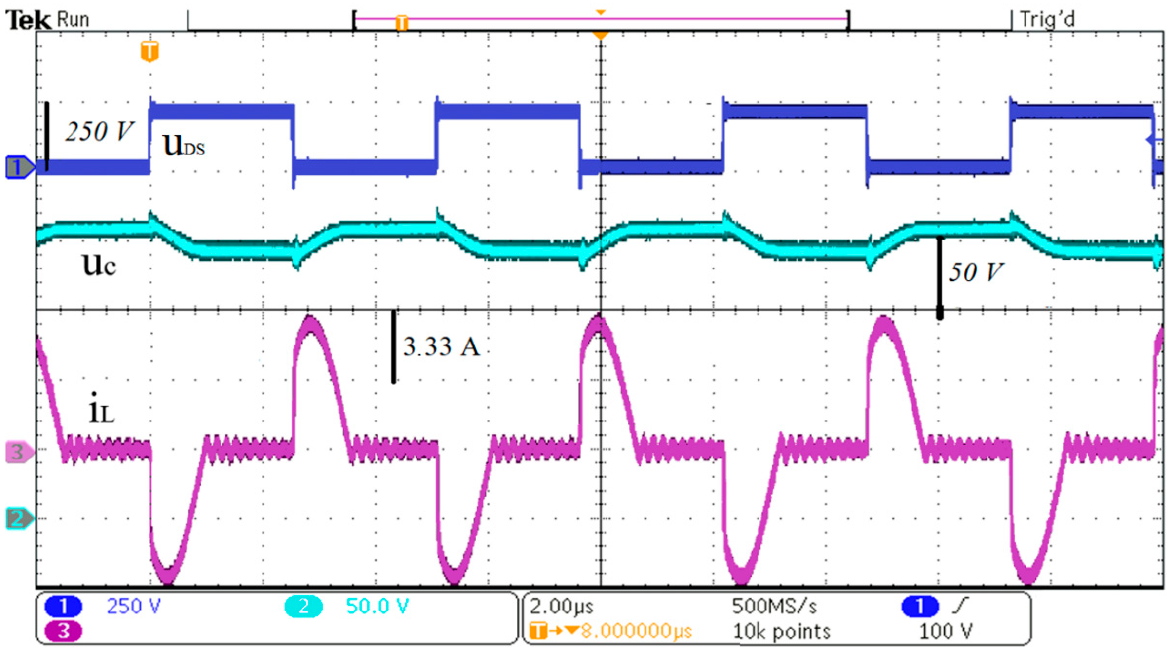
Figure 2. Experimental steady-state waveforms [14] at P out = 700 W of the MOSFET drain-source voltage (CH1) and the switched capacitor voltage and current (CH2, CH3).